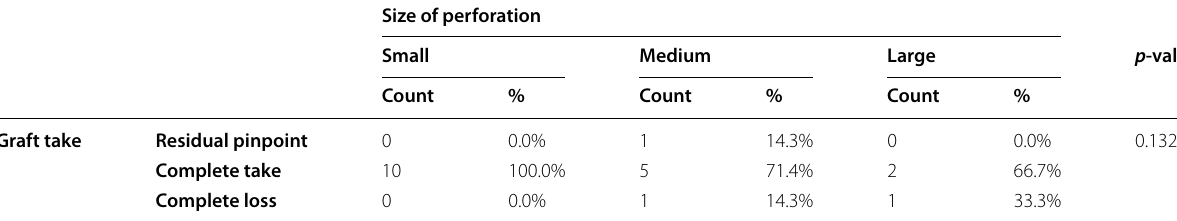
Table 3 Relation between size of perforation and successes of graft